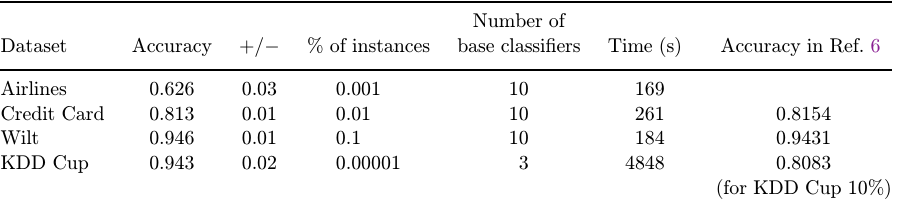
Table 2. Experiments results.